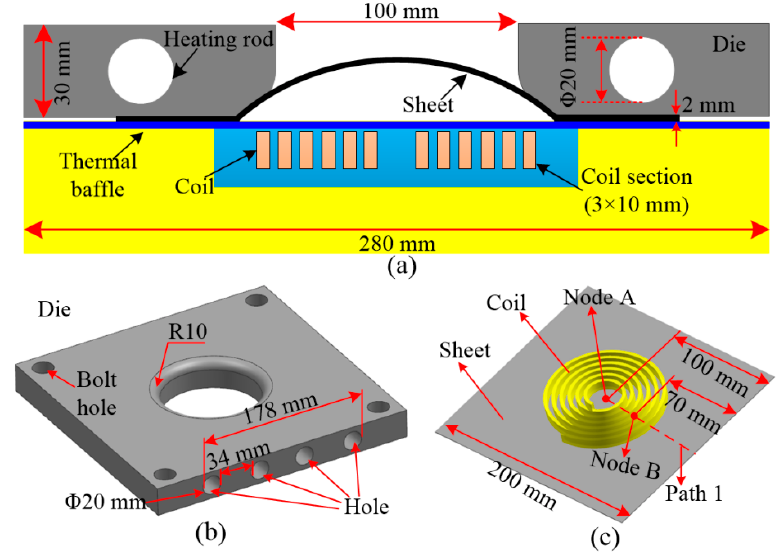
Figure 2. Structure of electromagnetic hot forming: ( a ) forming diagram; ( b ) forming die; ( c ) coil and sheet.